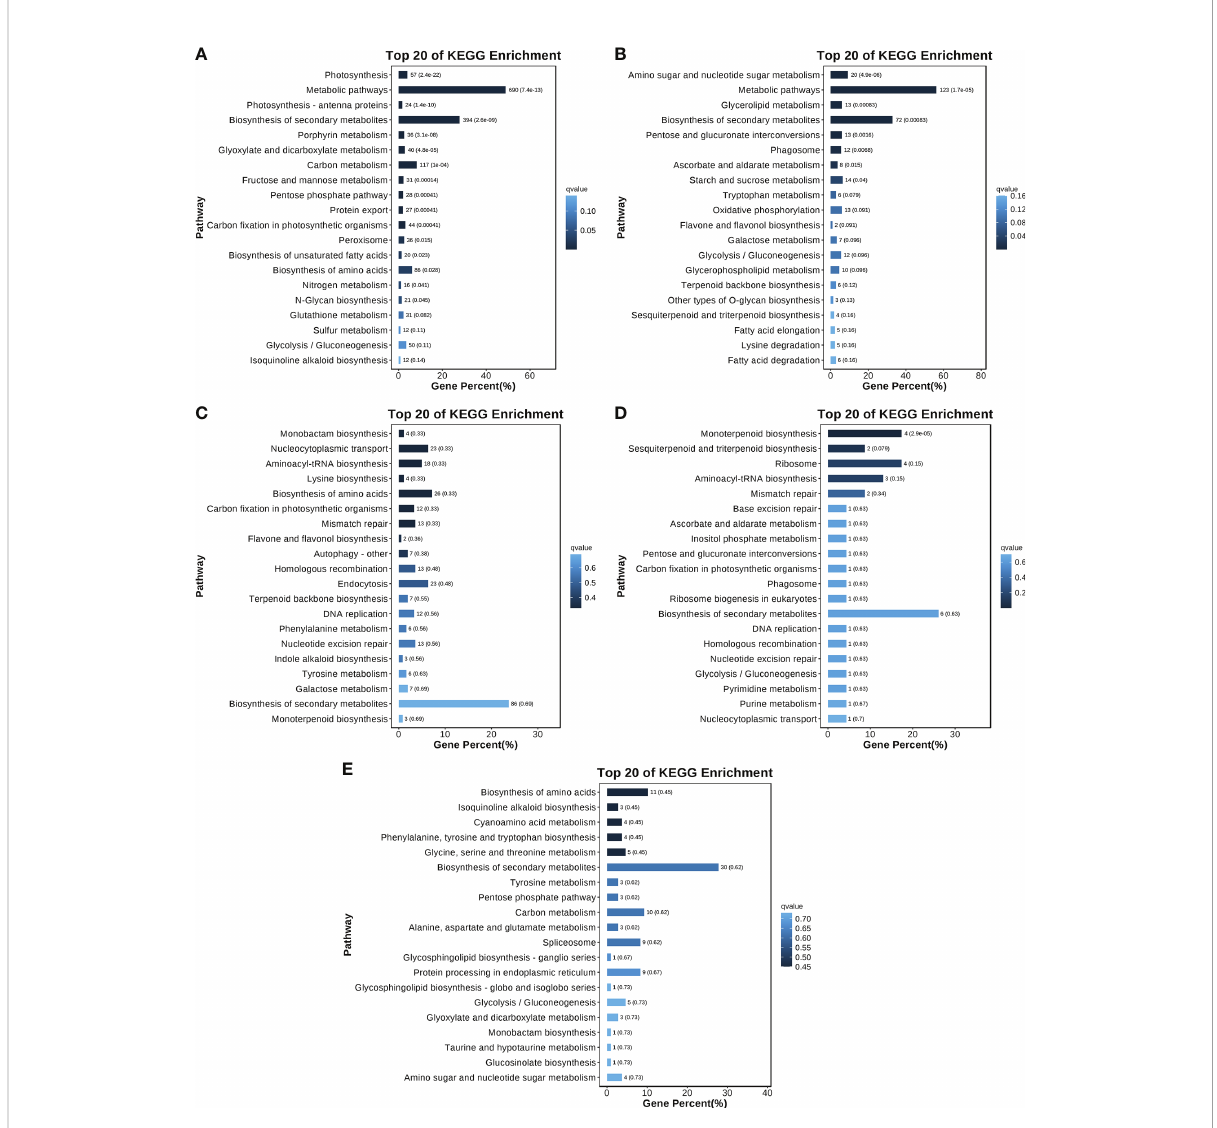
FIGURE 7 KEGG analysis of different modules. (A – E) Twenty most enriched KEGG pathways in the turquoise, red, blue, light cyan, and cyan modules, respectively. The y-axis presents the KEGG pathways, whereas the x-axis presents the proportion of the genes assigned to a particular pathway. Increases in the color intensity re fl ect decreases in the P/Q value. The values next to each bar represent the gene number and the P/Q